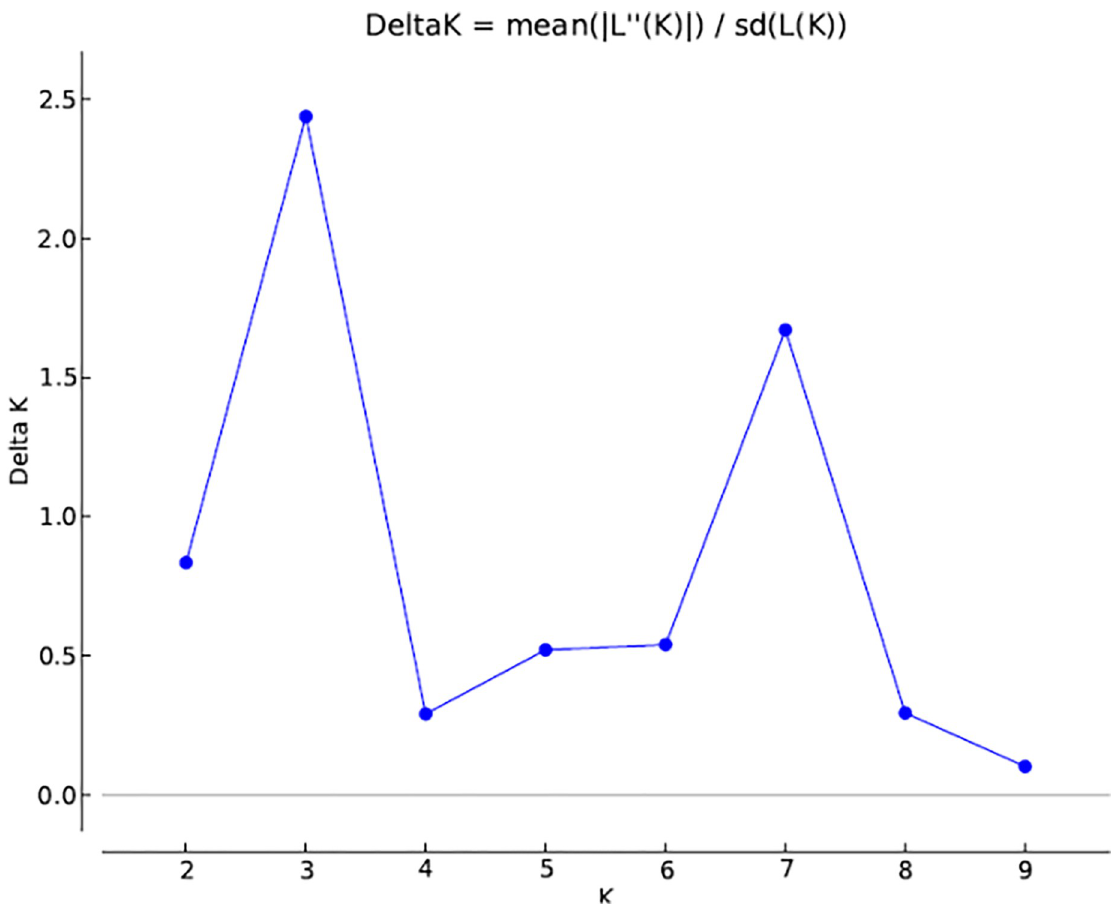
Fig 1. The result obtained of 83 genotypes (23 parents and 60 hybrids) using 92 SSR molecular markers using Structure Harvester analysis.